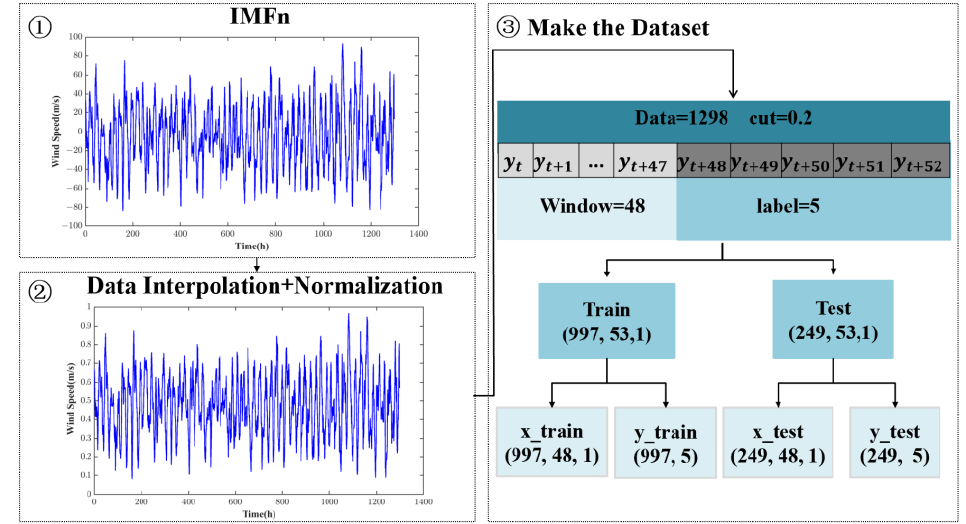
Figure 2. Data preprocessing flow chart. The x_train is the training set data and the y_train is the label of the x_train. The x_test is the test set data and the y_test is the label of the